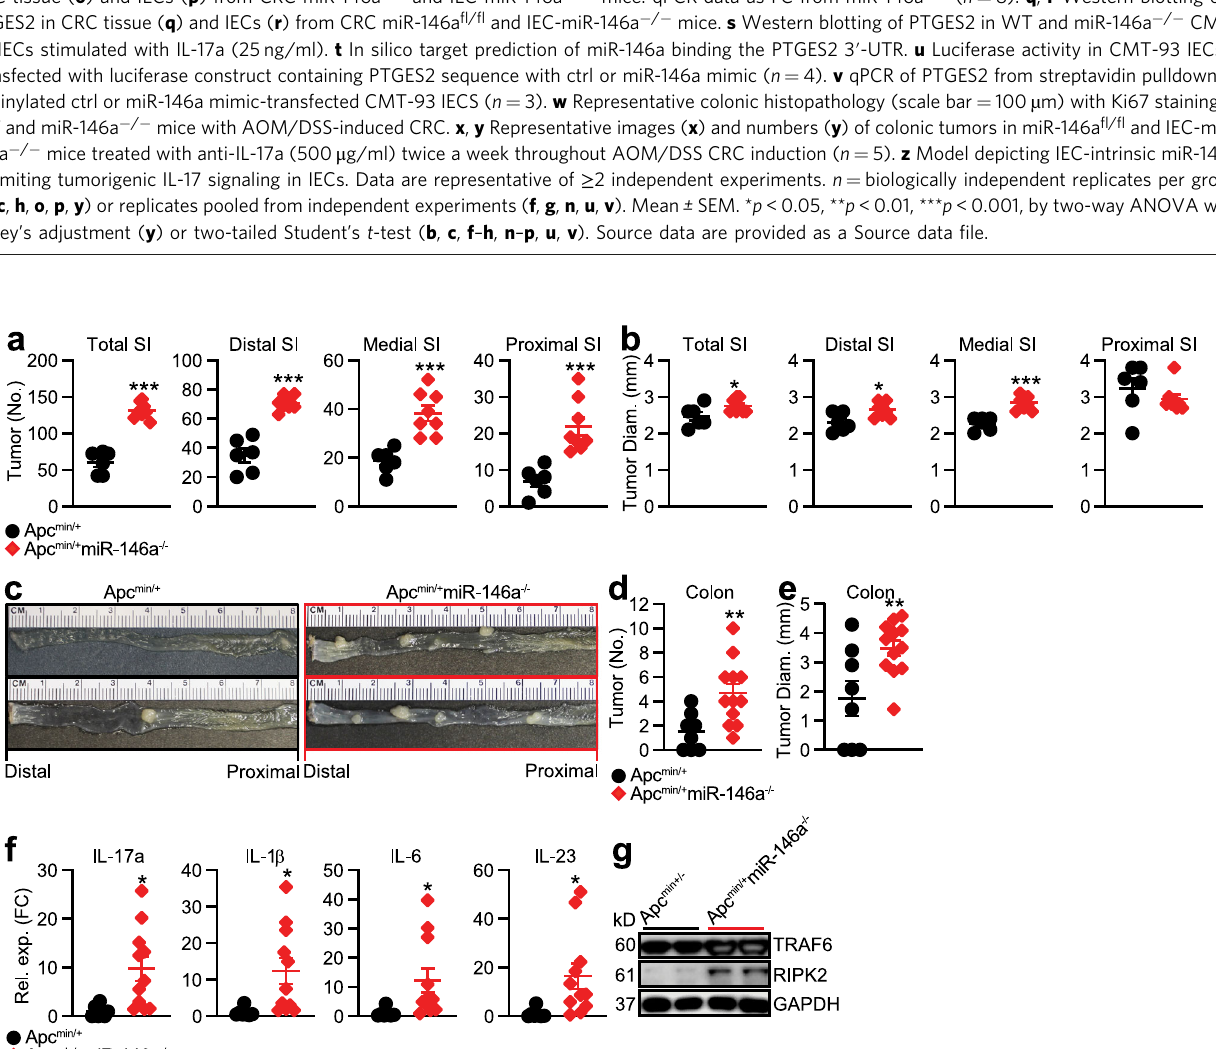
Fig. 5 MiR-146a de fi ciency promotes spontaneous tumor development in Apc Min/ + mice. a , b Small Intestine (SI) tumor numbers ( a ) and sizes ( b ) of Apc Min/ + and Apc Min/ + miR-146a − / − mice at 22 – 24 weeks of age ( n = 6 – 8). c – e Representative images ( c ), numbers ( d ), and sizes ( e ) of colonic tumors in Apc Min/ + and Apc Min/ + miR-146a − / − mice at 22 – 24 weeks of age ( n = 8 – 12). f qPCR of IL-17 and IL-17-inducing cytokines in colonic tumor tissue from these mice. qPCR data as FC from Apc Min/ + ( n = 8 – 12). g Western blottings of TRAF6 and RIPK2 in CRC tissue from these mice. Data are representative of ≥ 2 independent experiments. n = biologically independent replicates per group. Mean ± SEM. * p < 0.05, ** p < 0.01, *** p < 0.001, by two-tailed Student ’ s t -test ( a , b , d – f ). Source data are provided as a Source data fi (Apc Min/ + miR-146a − / − ), as mutations in Apc are responsible for driving sporadic CRC in humans 51 . We observed Apc Min/ + miR- 146a − / − mice developed greater numbers of tumors in both the small intestine (Fig. 5a, b) and colon (Fig. 5c – e) compared to that in WT Apc Min/ + mice. These data demonstrated that miR-146a also restricts spontaneous CRC.